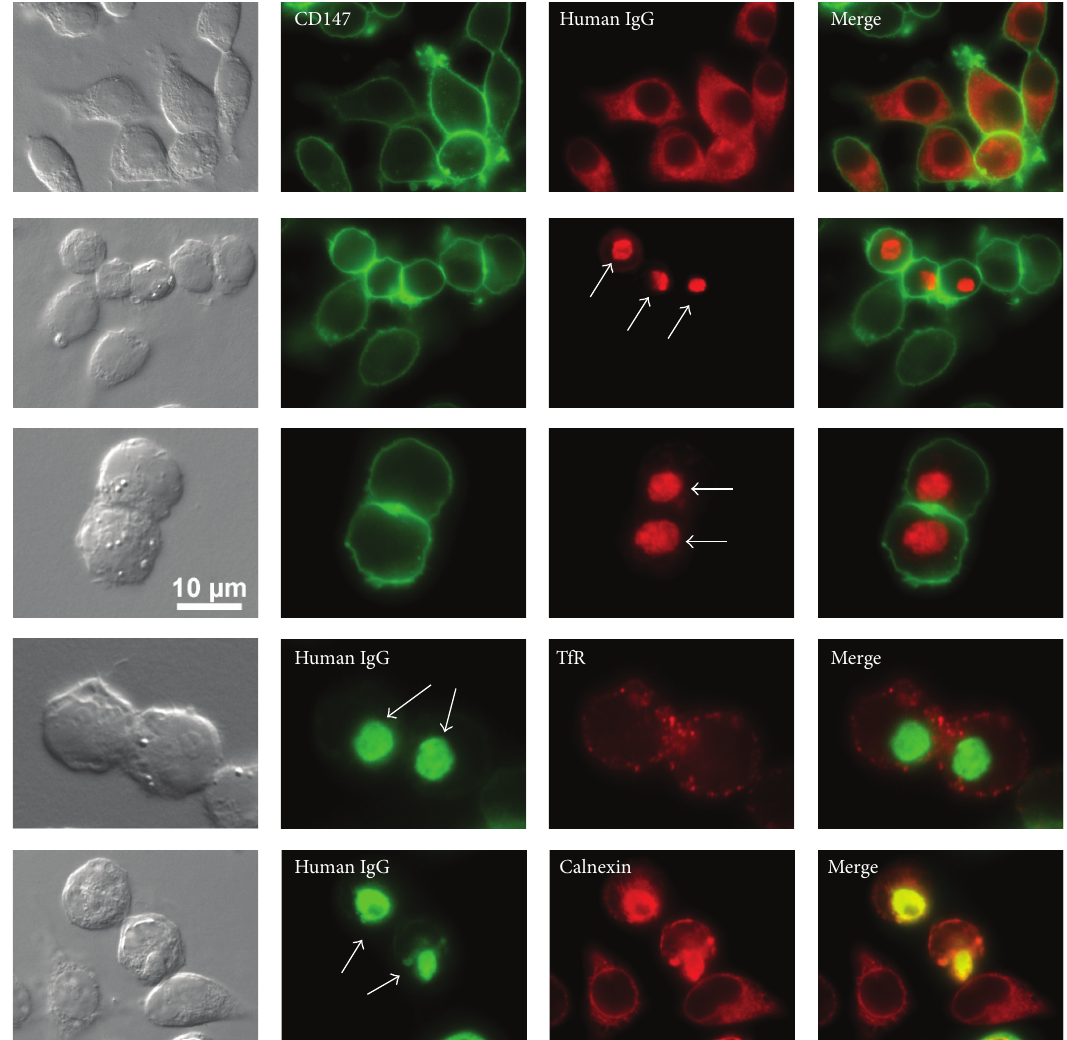
Figure 1: Immunofluorescent micrographs of HEK 293 cells expressing recombinant human IgGs. First three rows: cells were costained with anti-CD147 (green) and anti-human IgG (red). Fourth row: cells were costained with anti-human IgG (green) and anti-transferrin receptor (TfR) (red). Bottom row: Cells were co-stained with anti-human IgG (green) and anti-calnexin (red). Top row: the cells were transfected to express a high-secreting IgG clone. Recombinant human IgGs populated cytoplasmic reticular structures in transfected cells at steady state. Second row: cells express a low-secreting IgG clone. IgGs aggregated into Russell bodies in transfected cells. Russell bodies are pointed by arrows. Third through fifth rows: Russell body-housing cells are shown in a higher magnification. RB formation was typically accompanied by cell rounding in HEK 293